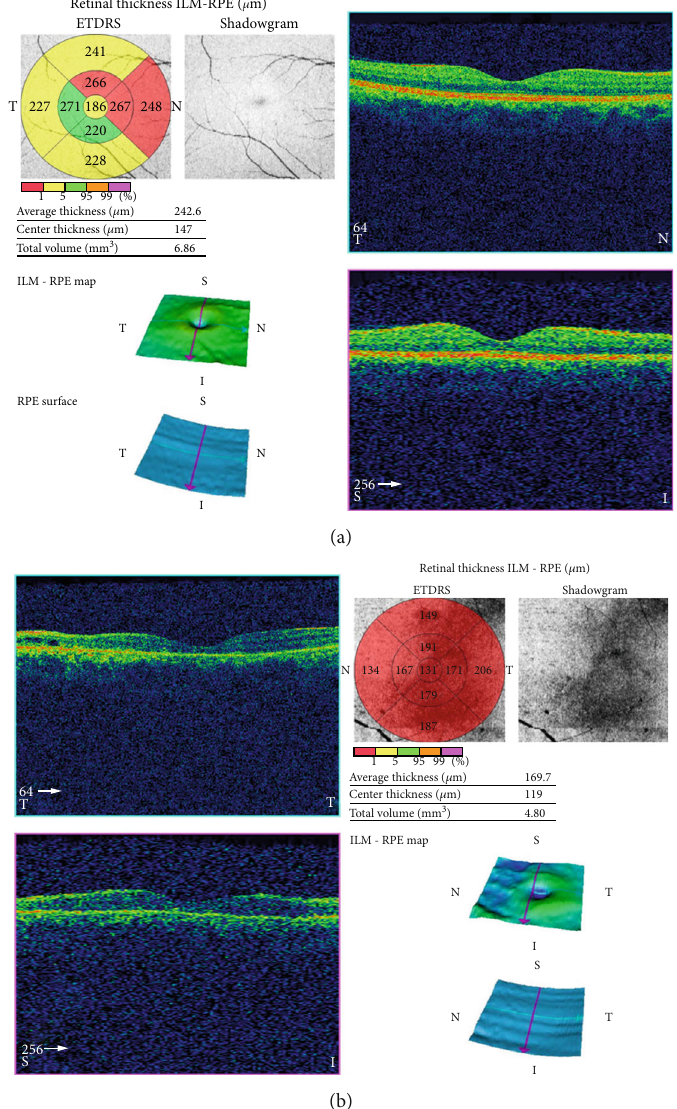
Figure 9: OCT at the end of two years follow-up. (a) Right eye with restoration of foveal anatomy. (b) Left eye with gross retinal